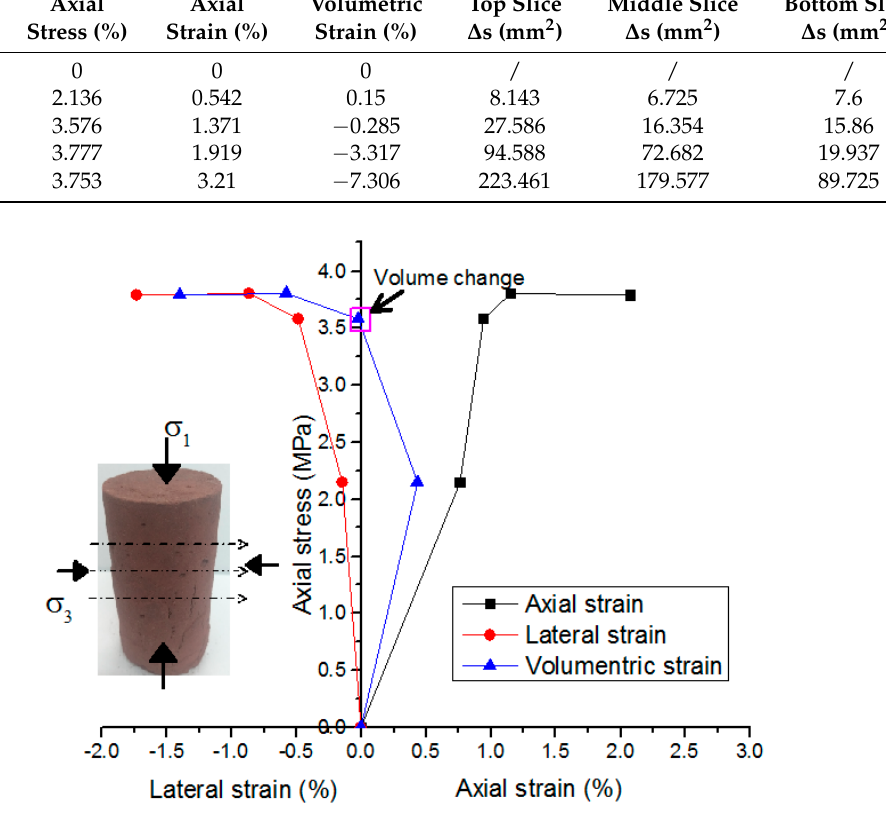
Figure 13. The axial, lateral, and volumetric stress–strain curves at the five CT scanning points.